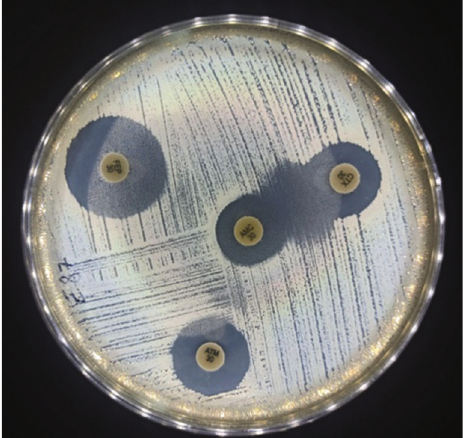
Figure 2: Synergy form between amoxicillin/clavulanic acid and